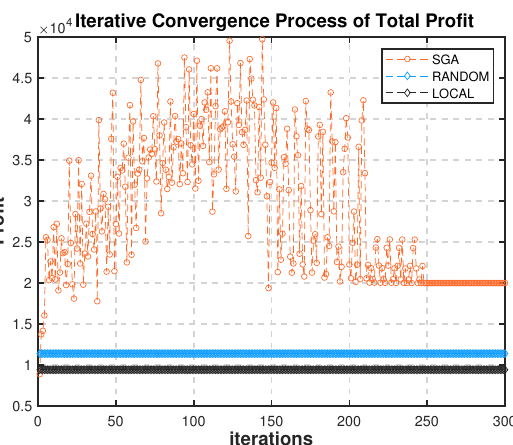
Figure 5. Iterative process of total profit of the system and comparison with random strategy.